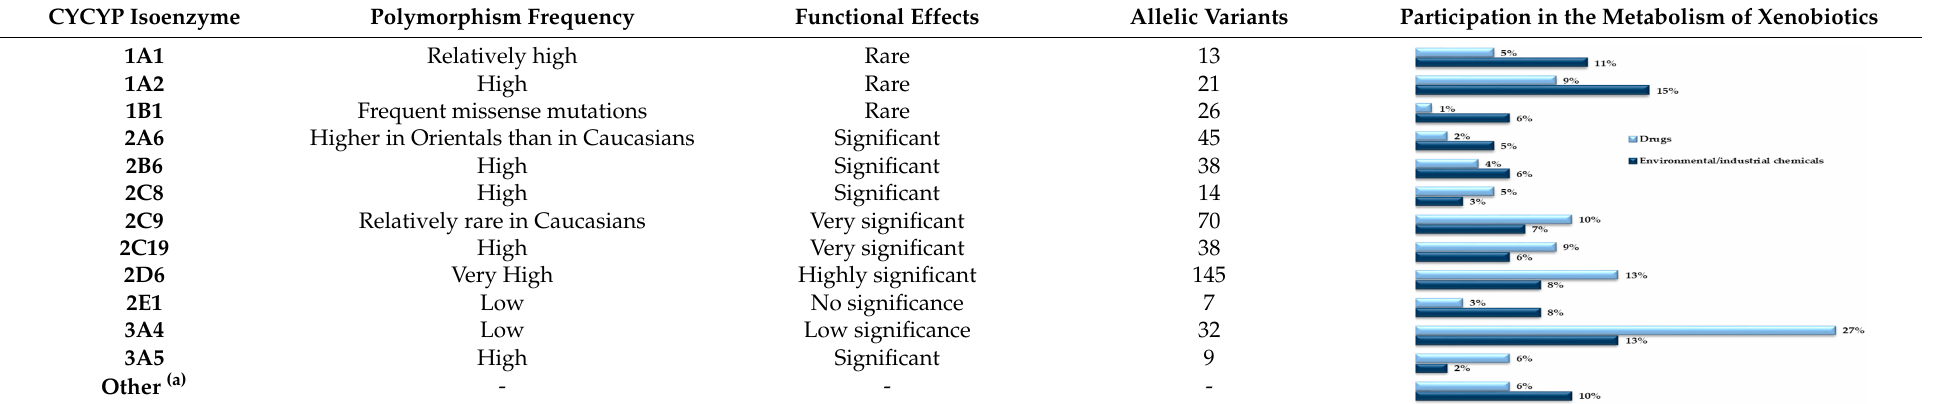
Table 2. Genetic variability and importance of the main CYP isoenzymes involved the metabolism of xenobiotics.